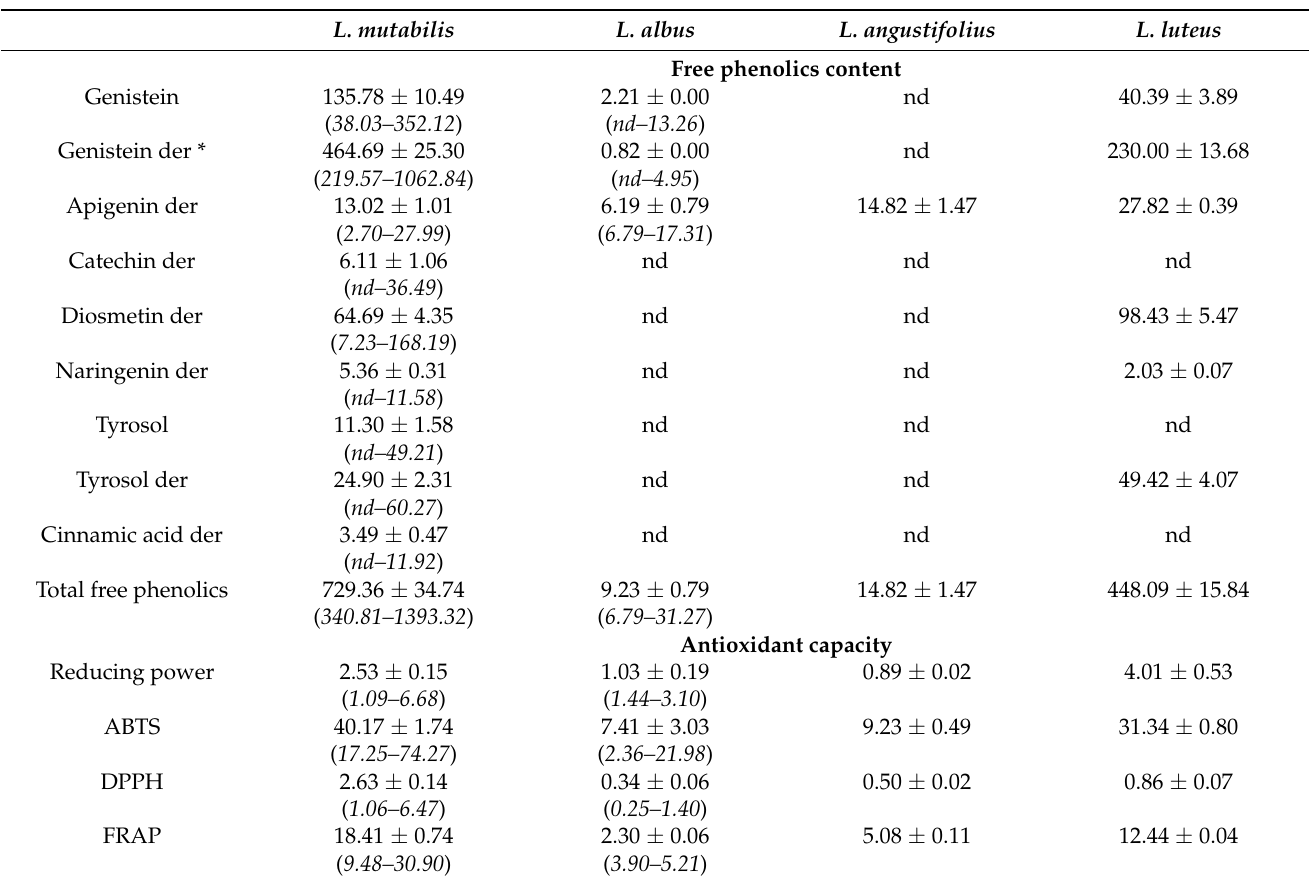
Table 1. Mean value ( ± standard error) of free phenolics content (mg/kg DM) and antioxidant capacity (mmol TE/kg DM) of debittered seeds of 33 L. mutabilis , three L. albus , one L. angustifolius and one L. luteus . In parentheses, the ranges of the values observed are